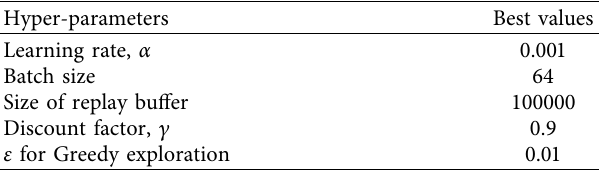
Table 5: Optimal hyper-parameters of DQN-based